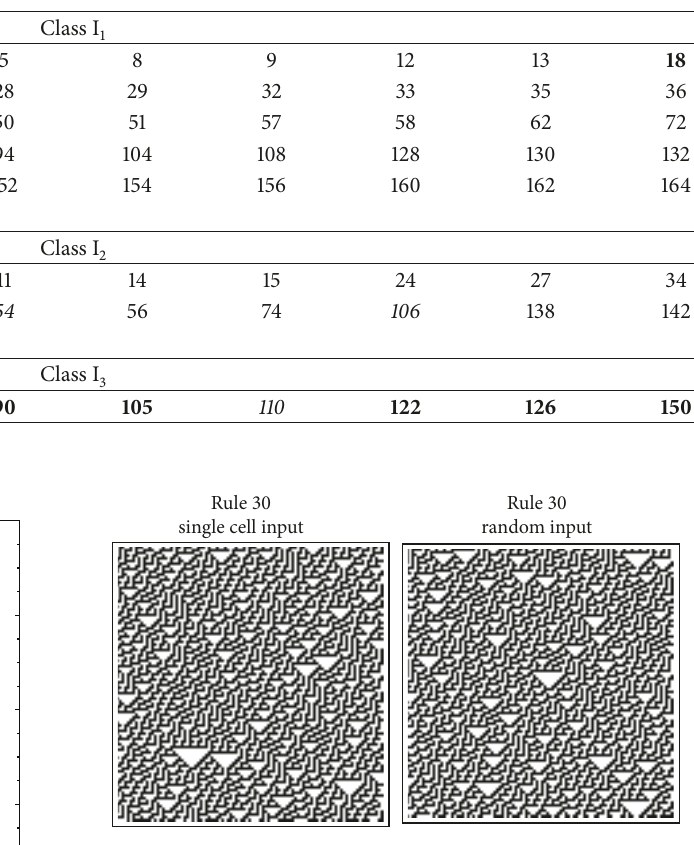
Figure 4: Time series for rule 30 generated by the two initial states of Figure 2. The similarity of the two outputs, each yielding color domains with a typical linear size of about ∼ 10 blocks, does not depend on the size of the CA and is responsible for the stability of Class I 3 rules to changes in